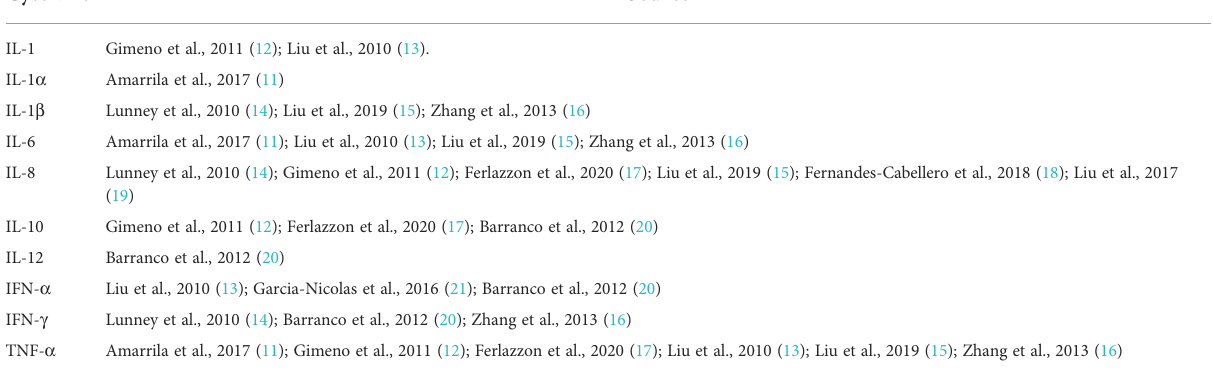
TABLE 1 In vivo cytokine production following experimental infection with PRRSV-1 or PRRSV-2.